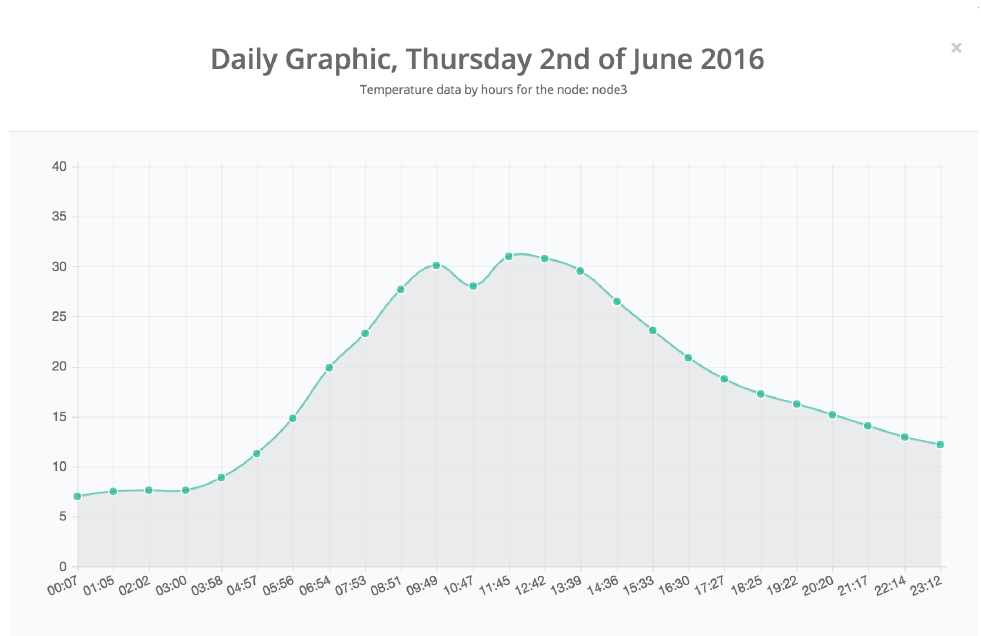
Figure 12. Temperature values collected by node 3 on an hourly